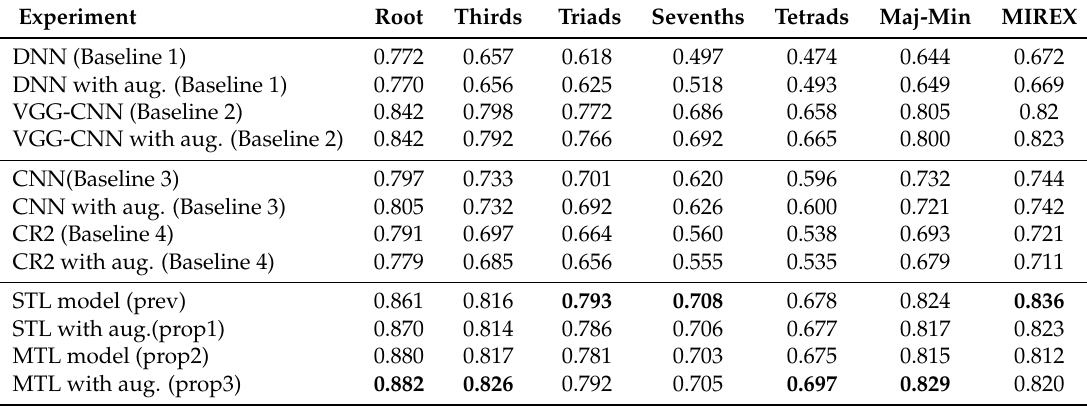
Table 6. Median-Weighted Recall Scores of the Compared Methods. The Best Values are Represented in Bold. (aug. refers to the augmented